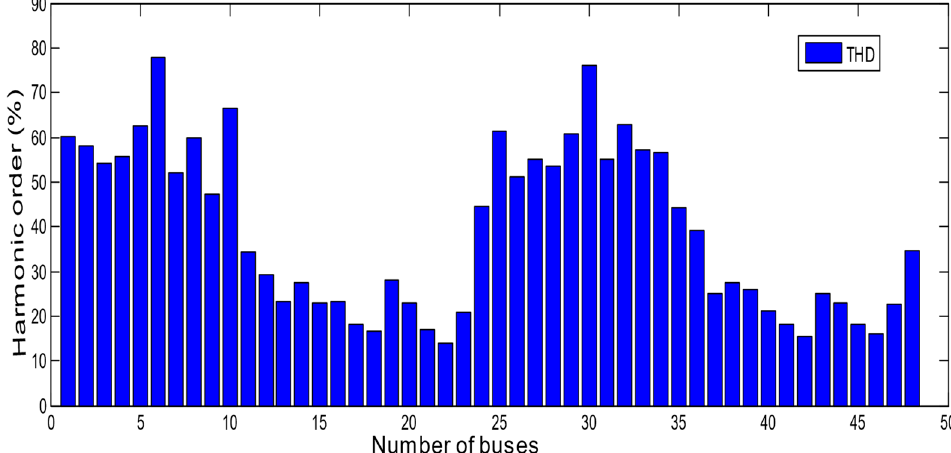
Figure 3. Total harmonic distortion at various buses on a 48 bus Nigeria power system.